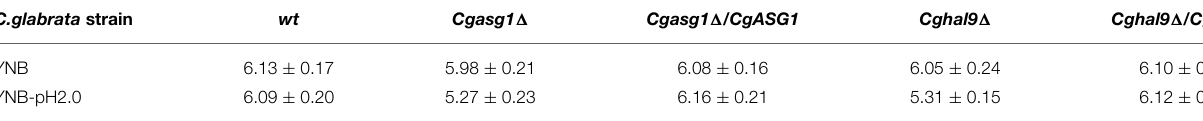
TABLE 2 | Intracellular pH of wild-type, mutant and complemented strains of C. glabrata as below a .